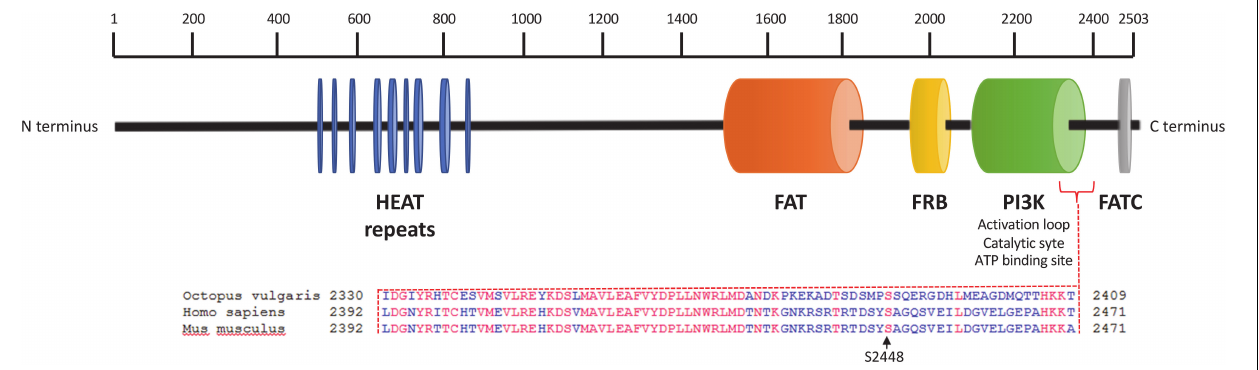
Frontiers in Physiology |